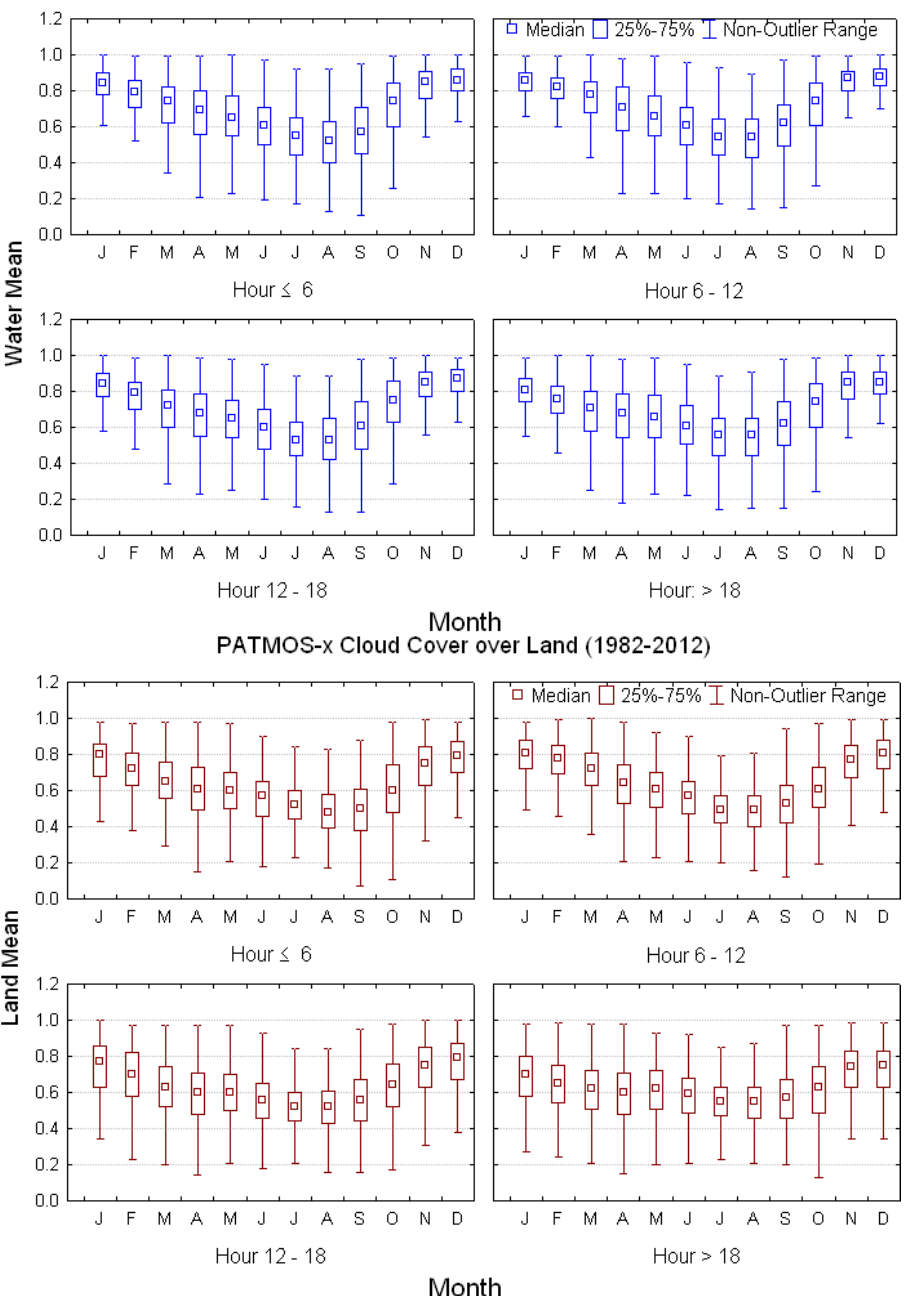
Figure 4. Box plot of the monthly mean cloud cover over the Great Lakes and surrounding land. The four plots represent four local time periods as denoted in the